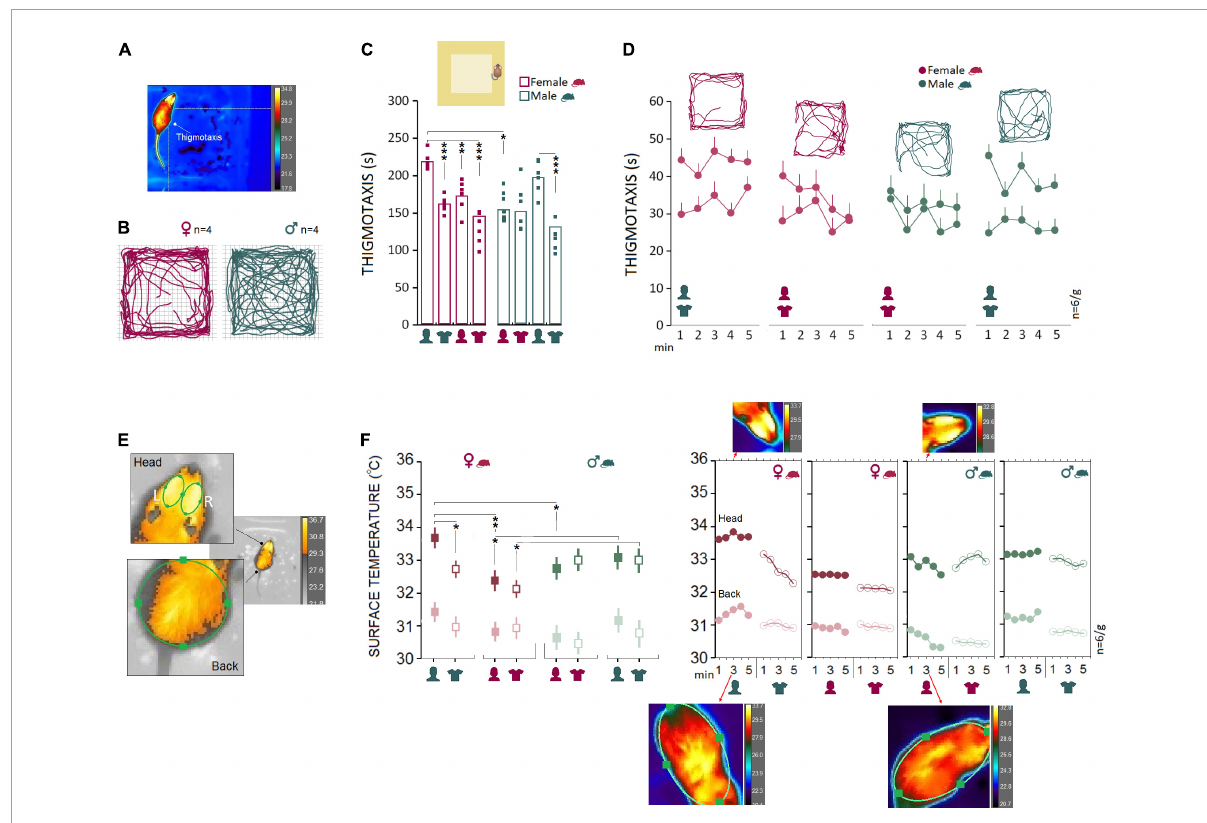
FIGURE2 Open field testing and IR imaging. (A) Exploratory movements of female and male rats were analyzed for thigmotaxis or the repetitive pattern of exploration near to the wall in the open field. (B–D) Thigmotaxis in Experiment 1 was significantly impacted when female rats were required to explore the open field in the presence of an opposite-sex experimenter. The multipath shown in the panel (B) motion track graphics compares thigmotaxis taken from four representative rats during Exp1. Small squares represent individual rats in each group and experimental session. (E) The IR thermographic imaging showing two regions of interest [head (left and right) and back] in assessments of surface temperature during the open field exploration. (F) Because there were no differences in the thermal responses between the left and right sides of the head, the average of cutaneous temperatures for the left and right sides were used. Females showed consistently higher cutaneous thermal temperatures than males for the head and back (left panel). The inset IR graphic output (right panel) provide samples of thermal differences in females and males in both ROIs. However, when animals were tested by same-sex experimenters in Experiments 3 and 4, male rats showed higher thermal responses than females in the head. * p ≤ 0.05, ** p ≤ 0.01, *** p ≤ 0.001; one-way and repeated-measure ANOVA, n = 6/group. Error bars show ±